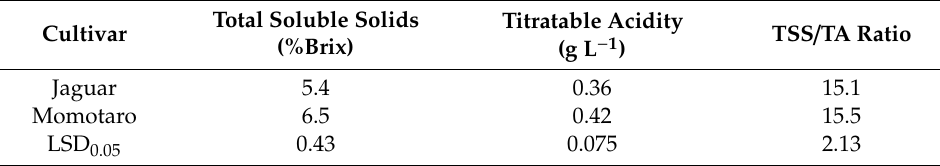
Table 6. Fruit quality of tomato as influenced by